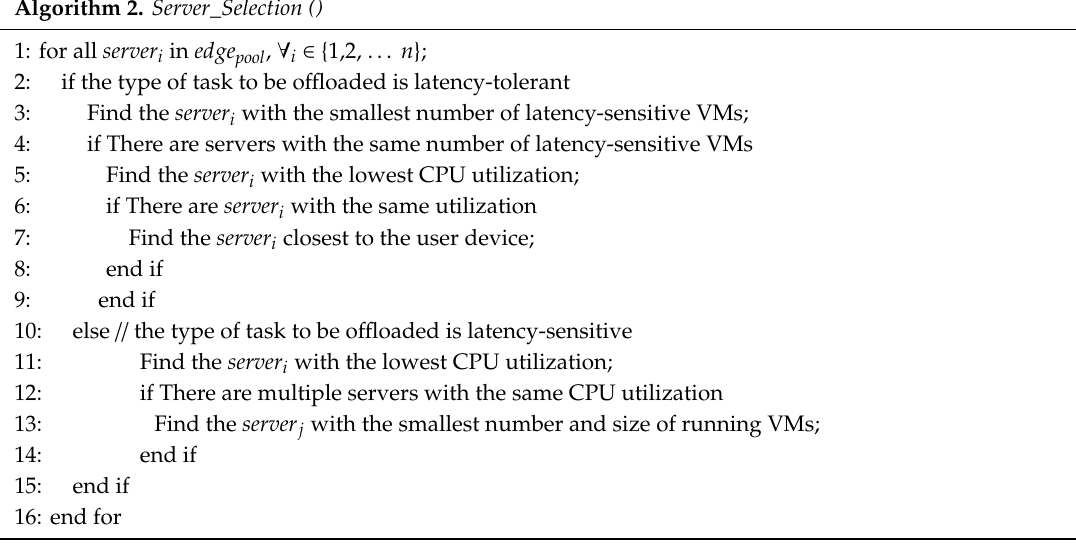
Algorithm 2. Server_Selection